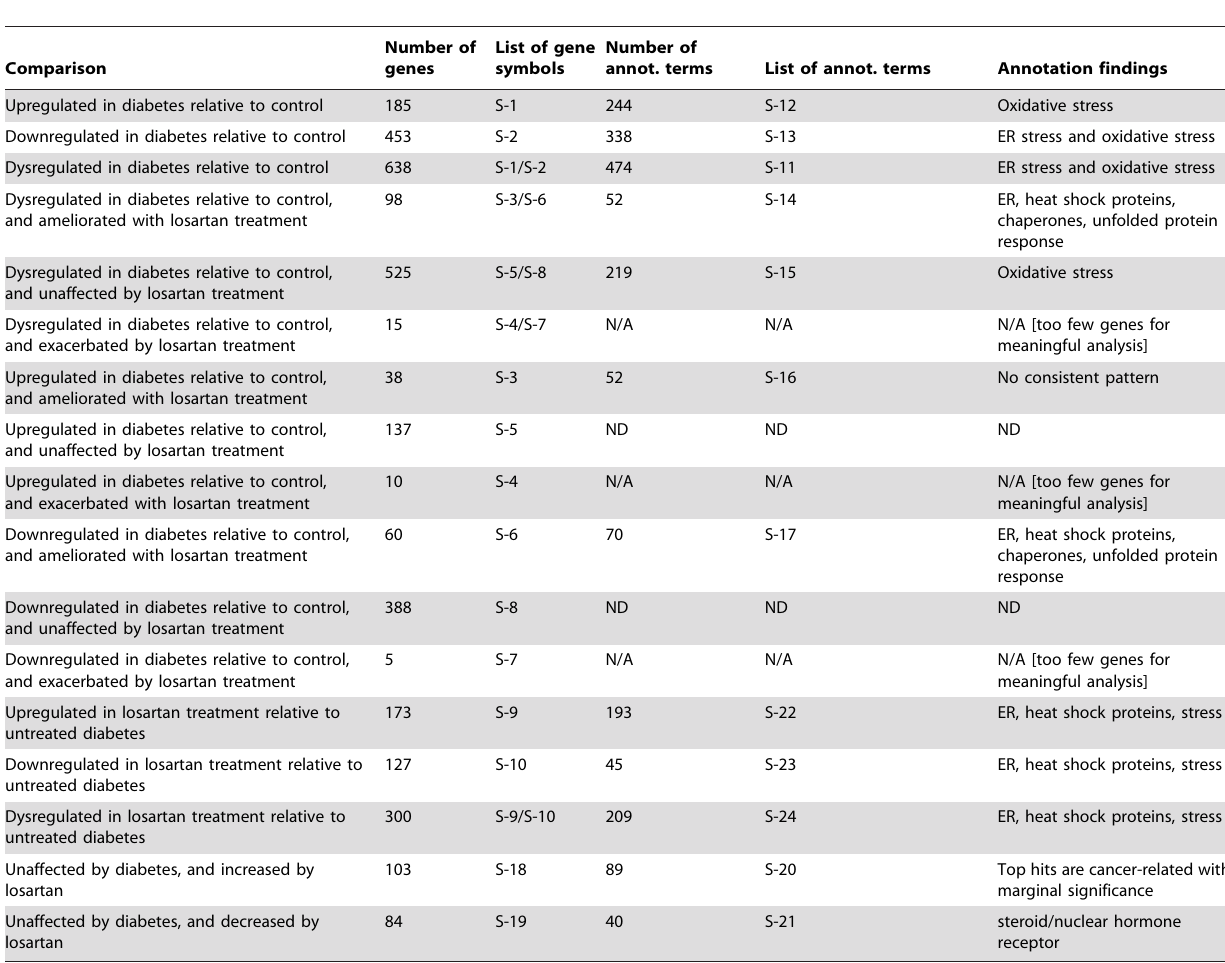
Table 4. Summary of gene expression comparisons and corresponding functional annotations (see text for details of individual